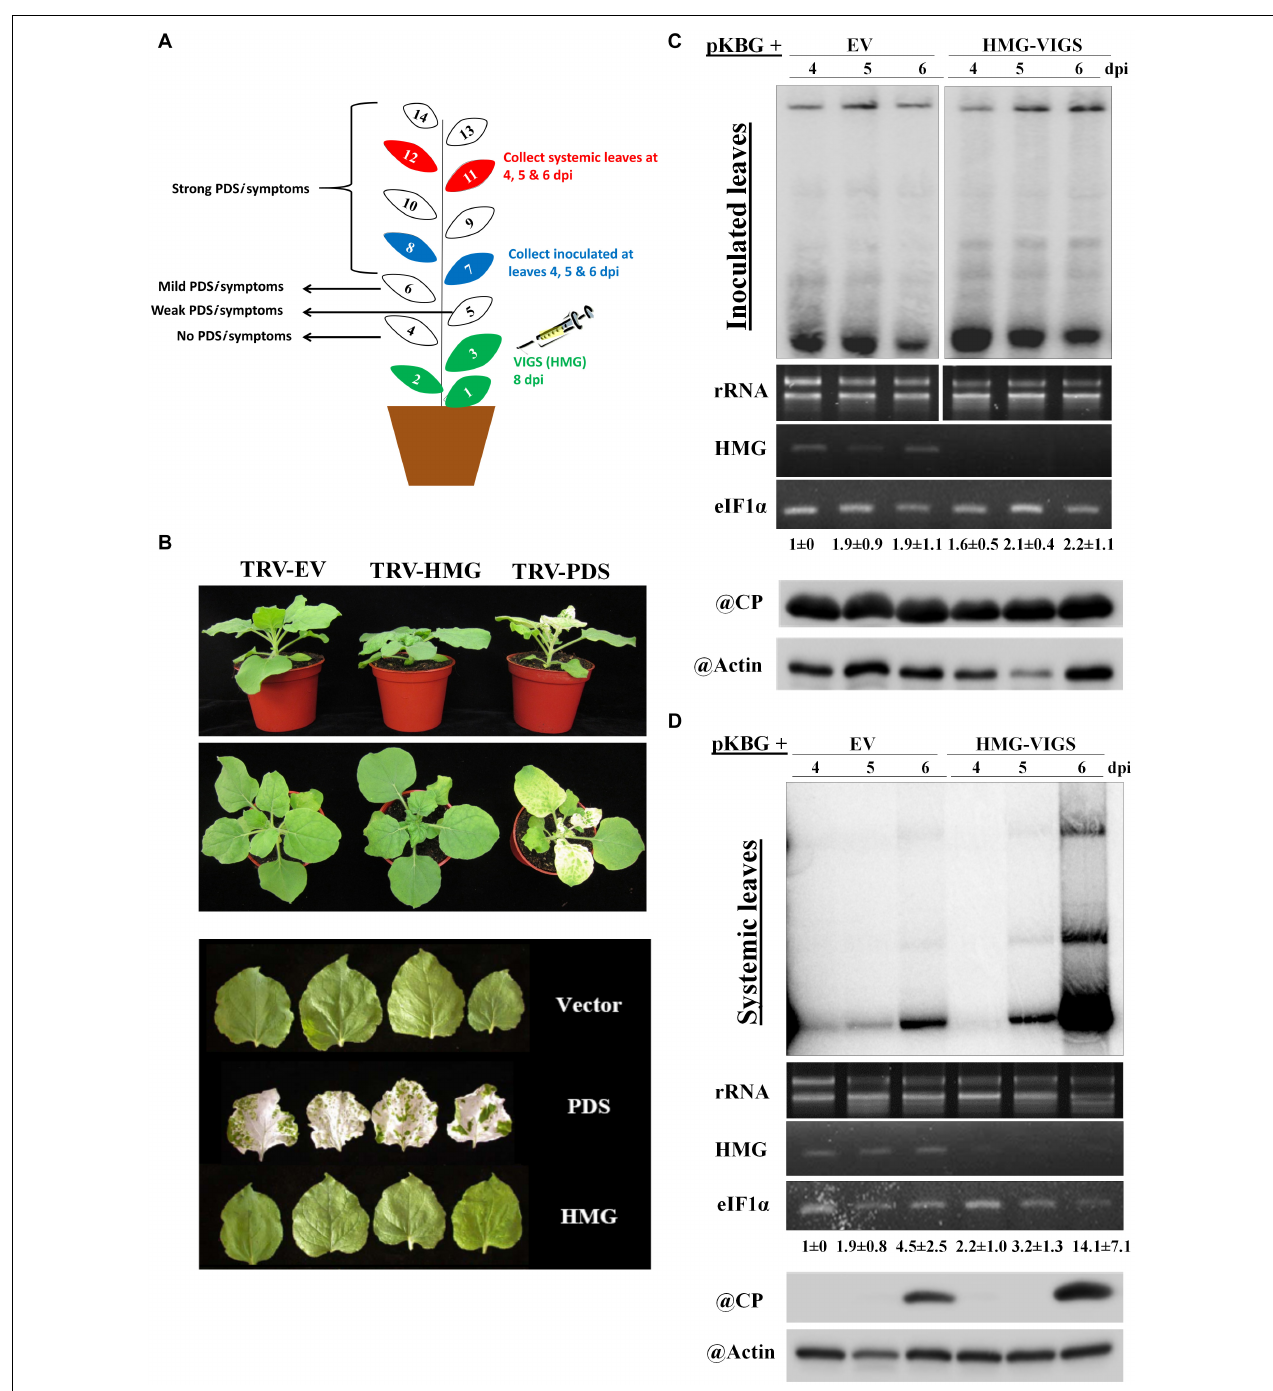
FIGURE 3 | Effects of silencing NbHMG1/2a on plant growth and resistance to BaMV. (A) Schematic illustration of our VIGS experimental design. The first three leaves of N. benthamiana plants were infiltrated with the silencing vector TRV carrying the NbHMG1/2a fragment or control mCherry fragment. Eight days later, leaves 7 and 8 were infiltrated with pBin61 carrying BaMV (pKBG). Inoculated leaves (leaves 7 and 8) and systemic leaves (leaves 11 and 12) were collected at 3, 4, and 6 days after BaMV infection (dpi). (B) Phenotype of NbHMG1/2a -silenced plants. Plants infiltrated with TRV-mCherry, TRV-HMG, and TRV-PDS. Photos were taken 8 days after agroninfiltration with TRVs. Upper and middle panel show plant height and spread, and lower panel shows leaf size. (C,D) RNA blot of BaMV in the inoculated leaves (C) and systemic leaves (D) of control plants (infiltrated with TRV-mCherry) and NbHMG1/2a -silenced plants (HMG-VIGS). The second panel represents rRNA levels as internal control. The third panel shows NbHMG1/2a levels in the control and silenced plants. eIF1 α was used as an internal control. Values represent average accumulation of BaMV genomic RNA from three biological replicates ± standard deviation. Lower panels represent protein blots of BaMV capsid protein (CP) (25 kDa) and actin in the control and silenced